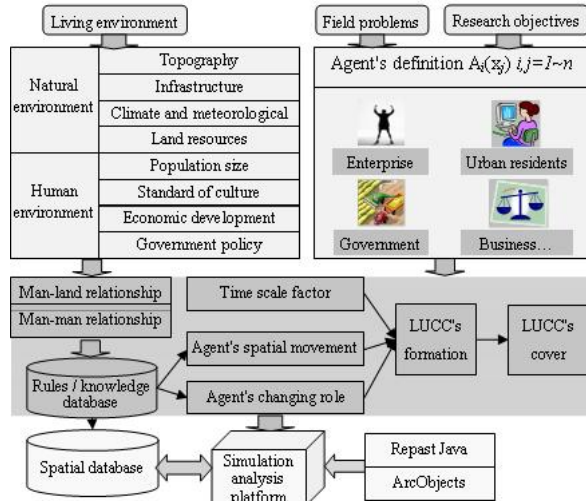
Figure 1. The Method of Modeling for ABM-LUCC Model by Using